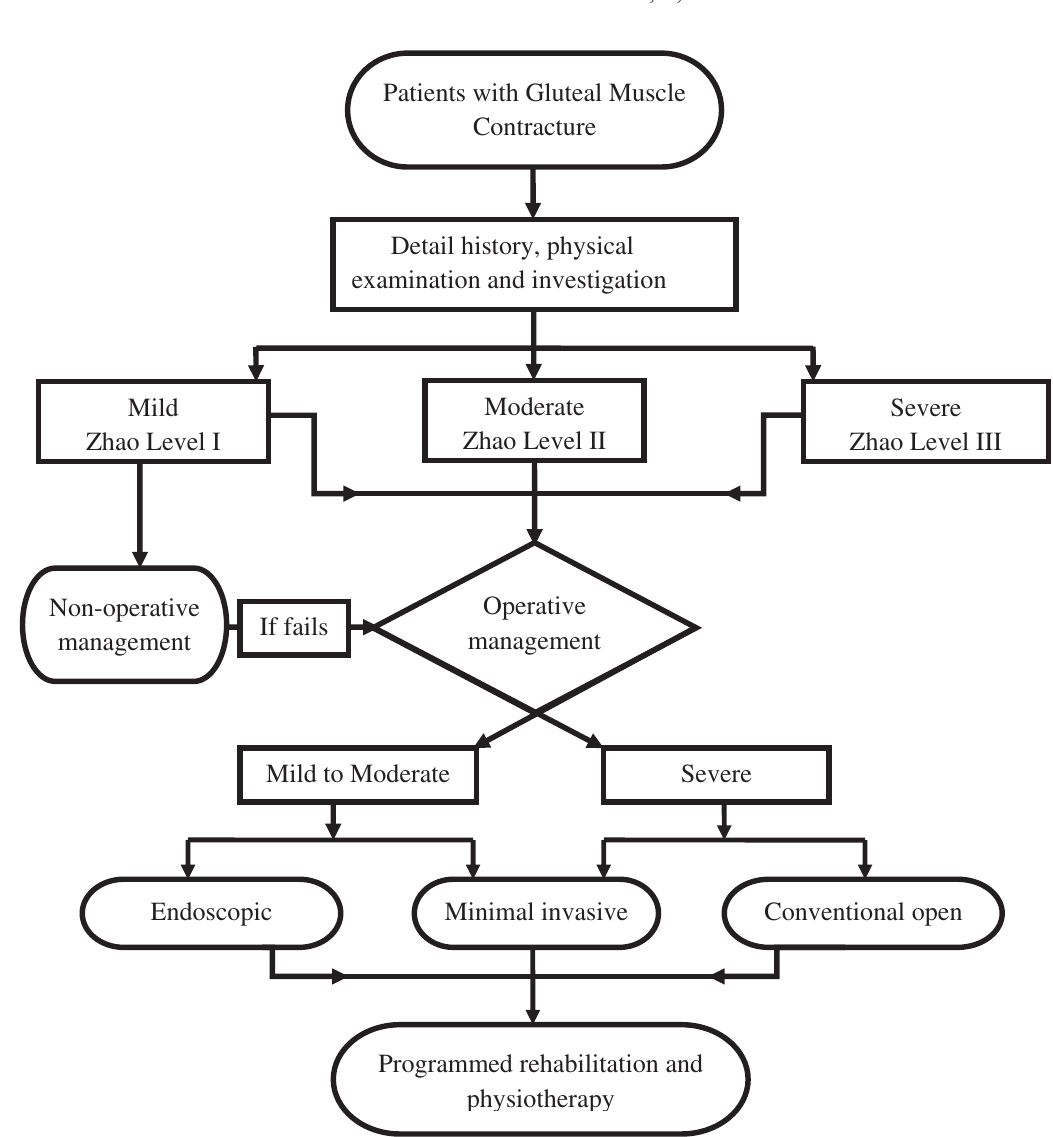
Figure 2. Flowchart of management options for gluteal muscle contracture